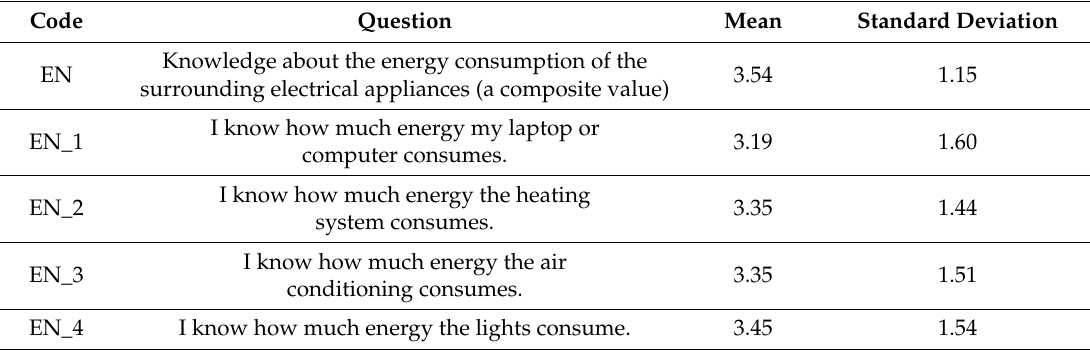
Table 10. Mean for knowledge about energy saving (fully disagree (1) to fully agree (5)).